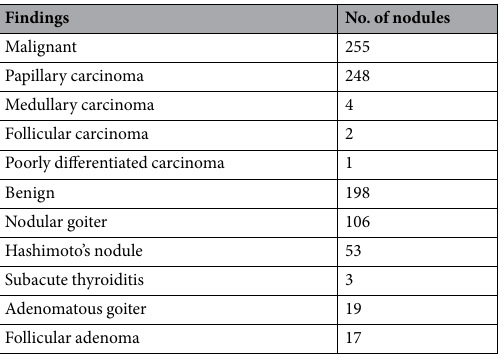
Table 1. Histopathologic findings in the 453 thyroid nodules treated with